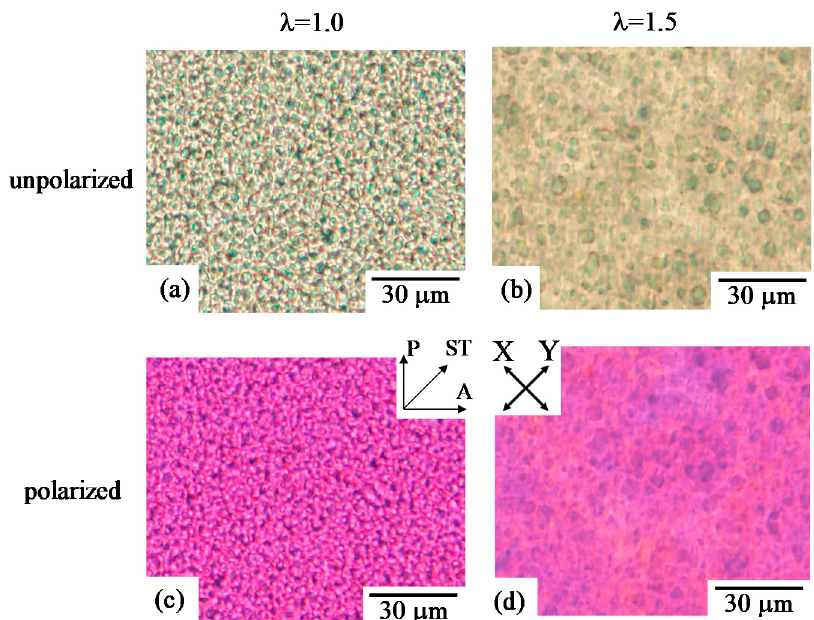
Figure 2. Unpolarized and polarized optical micrographs of 30/70 polycarbonate/poly(methyl methacrylate) (PC/PMMA) obtained by simultaneous biaxial stretching at draw ratios λ of 1.0 and 1.5. ( a ) λ = 1.0 (unpolarized); ( b ) λ = 1.5 (unpolarized); ( c ) λ = 1.0 (polarized); ( d ) λ = 1.5 (polarized).